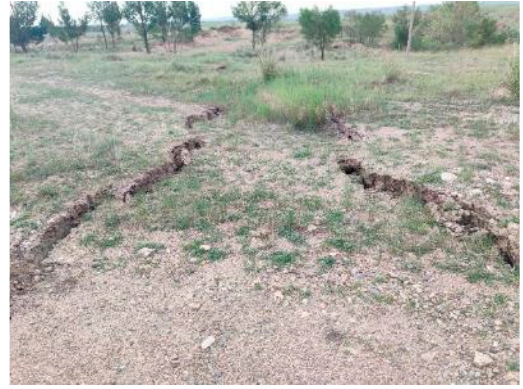
Figure 10. Fissures will form when the ground sinks at inconsistent rates. Plants located directly above the fissures will die immediately, but those around the fissures will still survive. Source: Built on the basis of the author’s field survey.